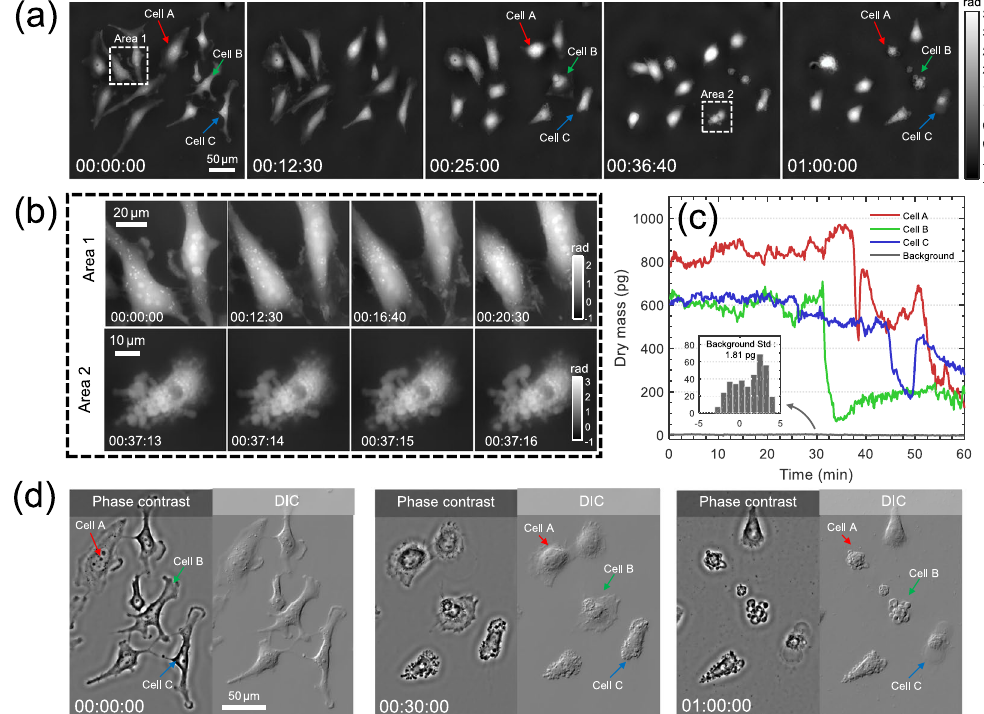
Figure 15. Multi-modal computational imaging of apoptotic HeLa cells induced by paclitaxel. The phase is reconstructed every second from the beginning of the drug treatment. ( a ) 5 representative quantitative phase images spanning over 1 h. ( b ) Magnified views at different time points corresponding to regions of interest (Areas 1 and 2). ( c ) Dry mass changes of three labeled cells during apoptosis. ( d ) Simulated phase contrast and DIC images at three time